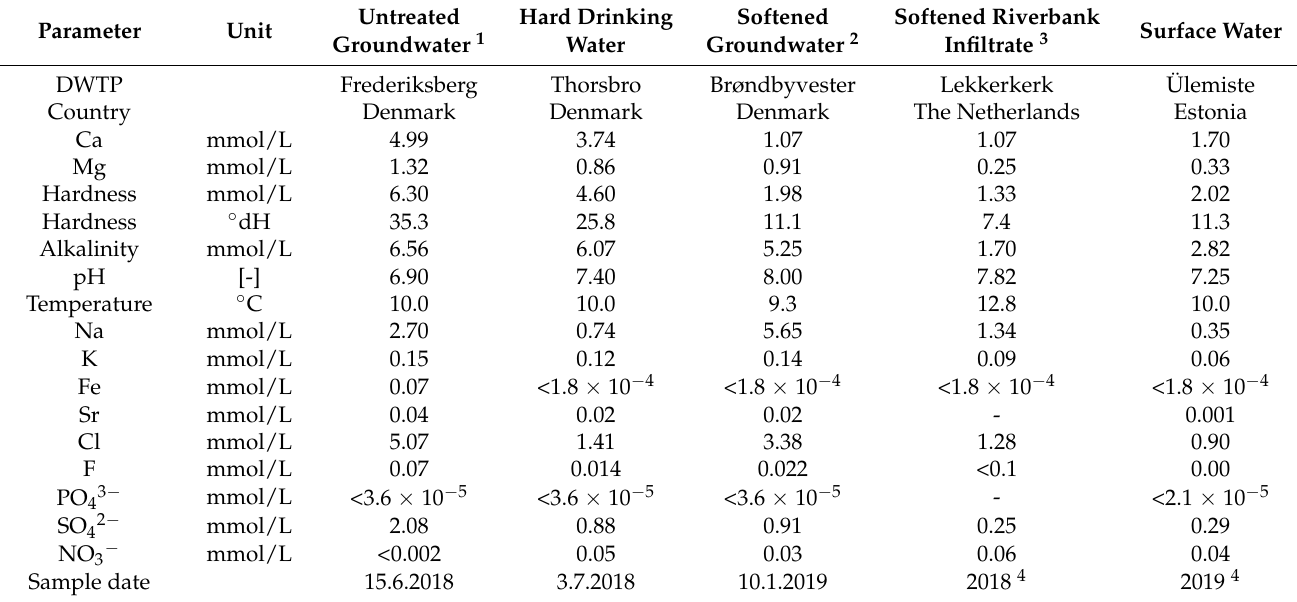
Table 2. Selected water types for demonstrating and evaluating procedure for CCPP